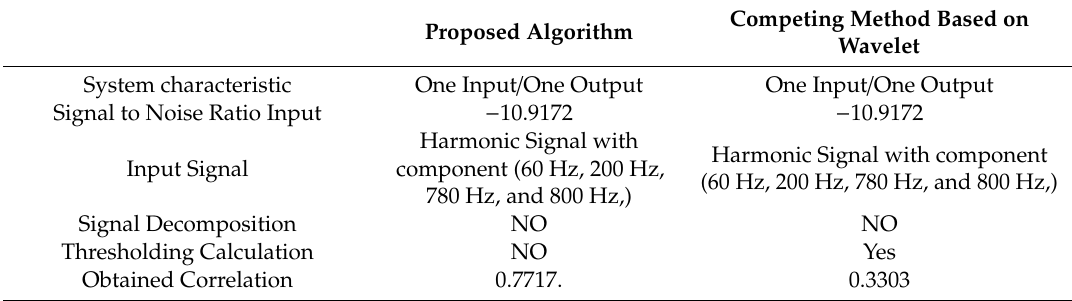
Table 2. Summary of the characteristic for the comparison with the method using wavelet